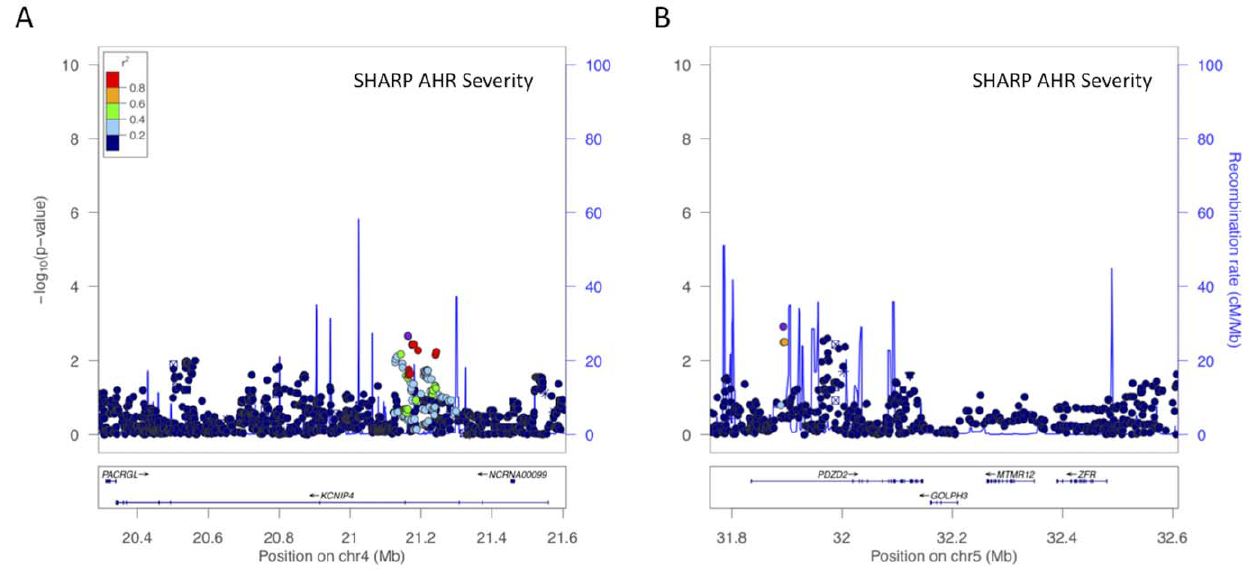
Figure 7. Top regions of association in a human AHR GWAS. (A) KCNIP4 and (B) PDZD2/GOLPH3/MTMR12/ZFR associations in SHARP. The x- axis denotes position along corresponding human chromosome, while the y-axis denotes –Log 10 (P). LD between the SNPs with the lowest P-value to other SNPs in the plots are denoted in colors and were computed according to HapMap Phase 2 CEU data using LocusZoom [55].